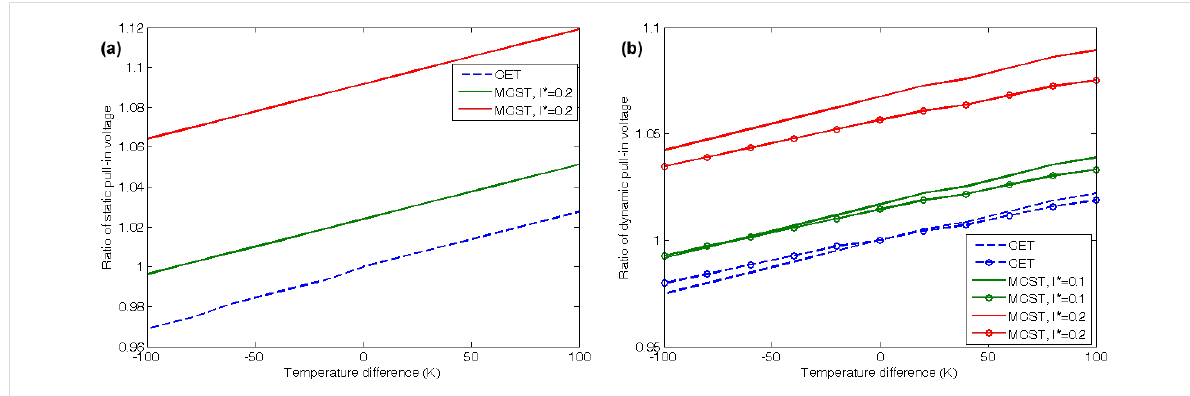
Figure 9: Effects of a variation in temperature on (a) the static, (b) the dynamic pull-in voltages of the doubly clamped CNTs.